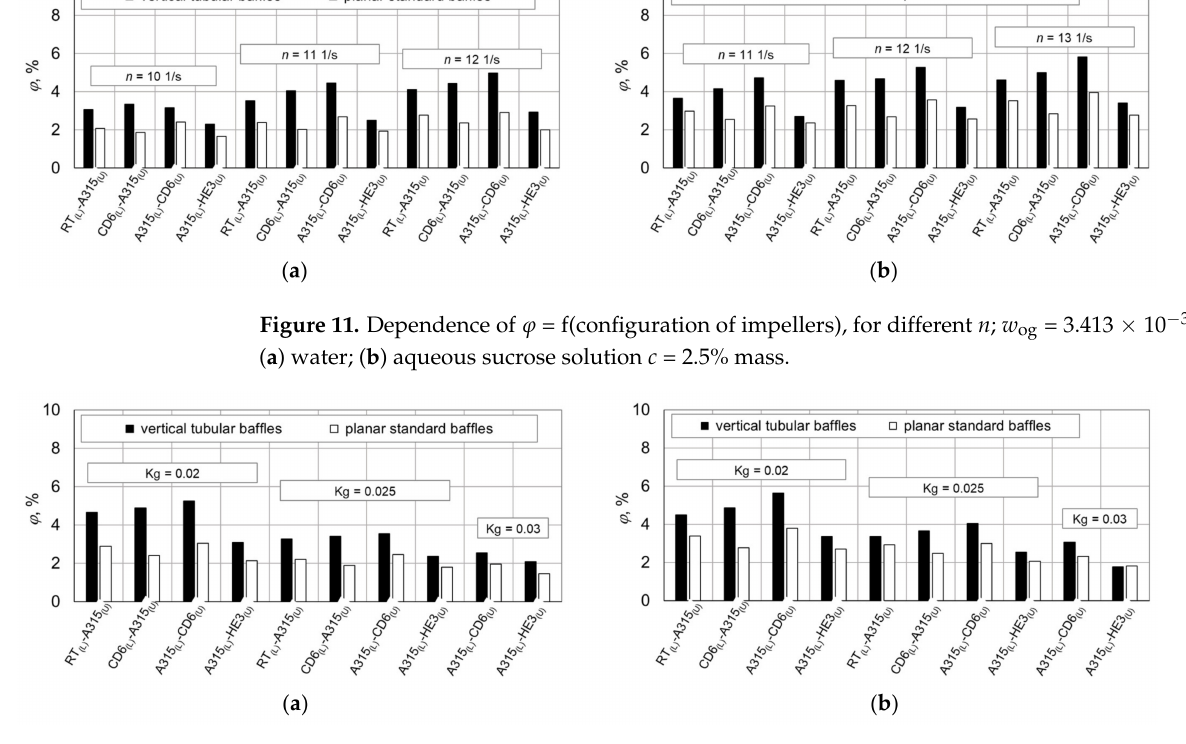
Figure 12. Dependence of ϕ = f(configuration of impellers), for different Kg; w og = 3.413 × 10 − 3 m/s; ( a ) water; ( b ) aqueous sucrose solution c = 2.5%